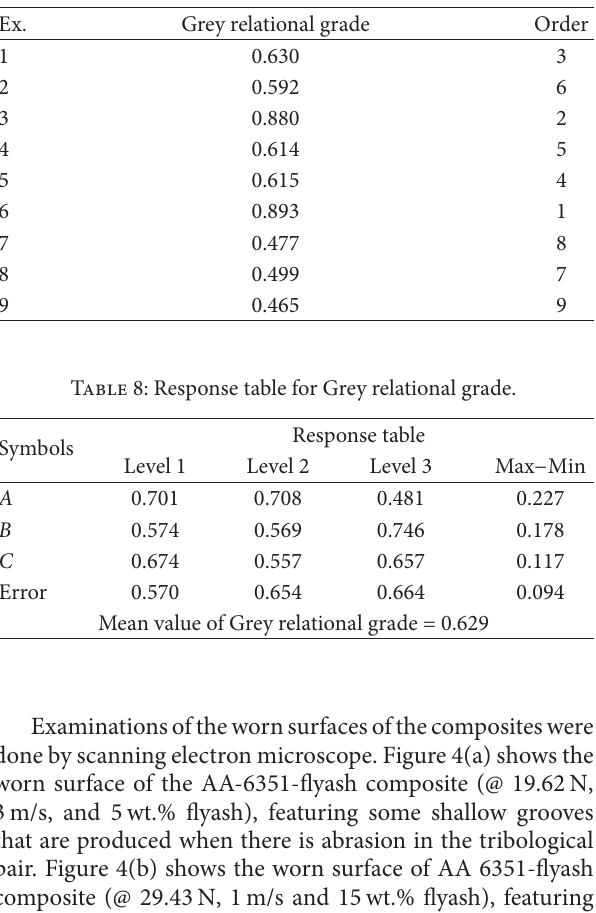
T 5: Preprocessed data results.